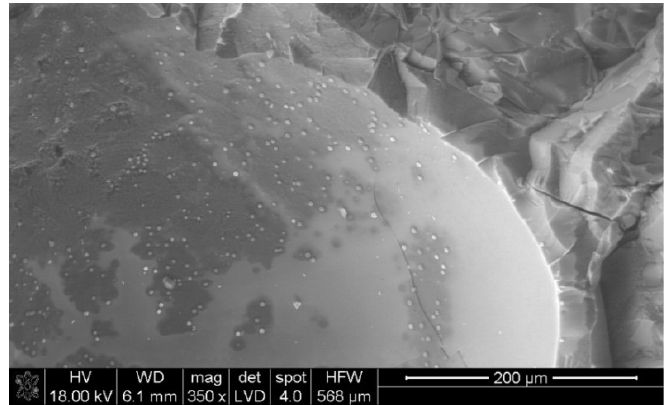
Figure 8. SEM-EDX sample identified as CuCon3.